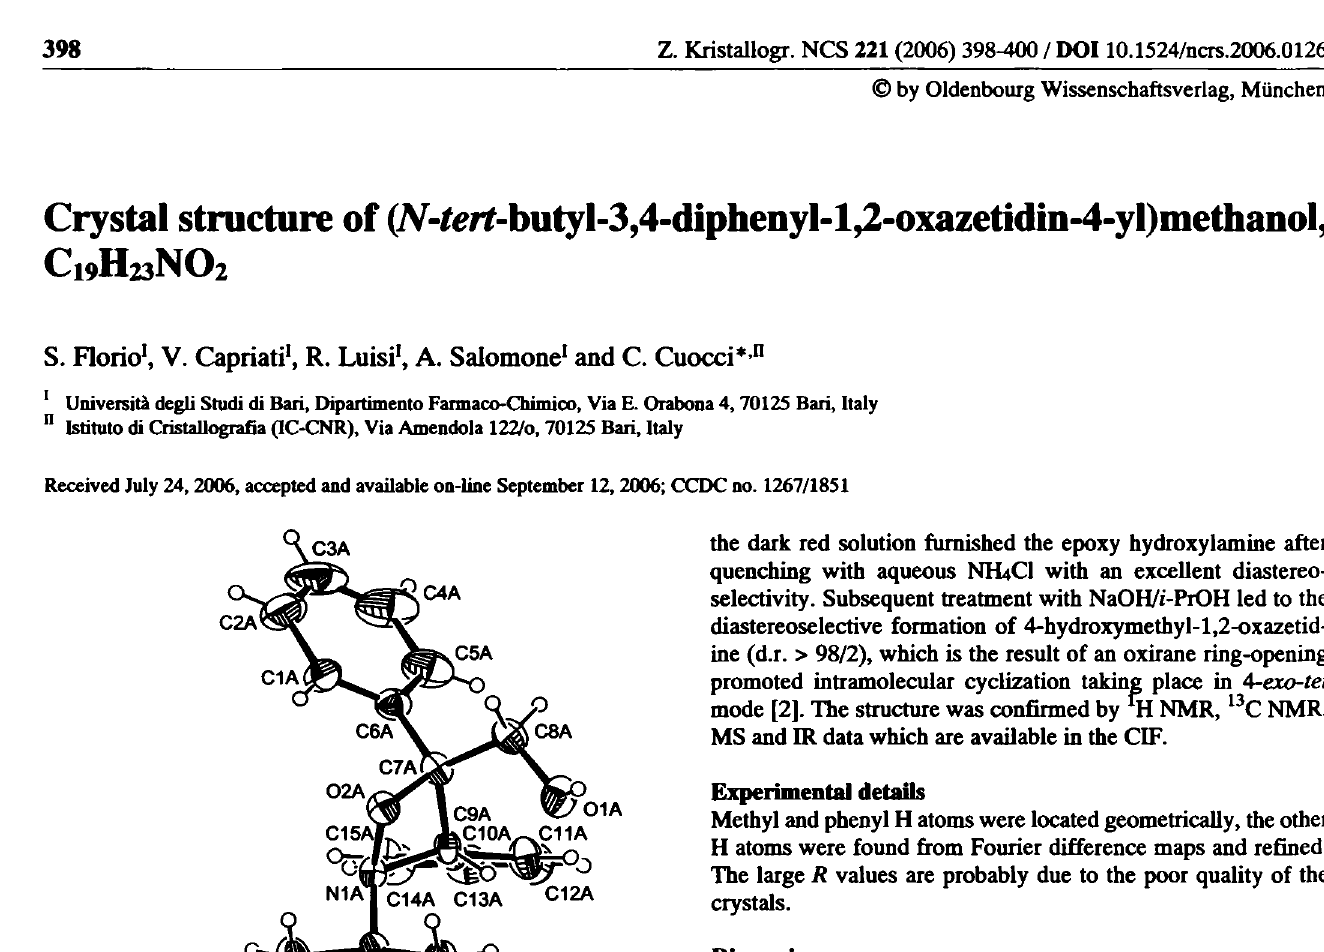
Table 1. Data collection and handling.